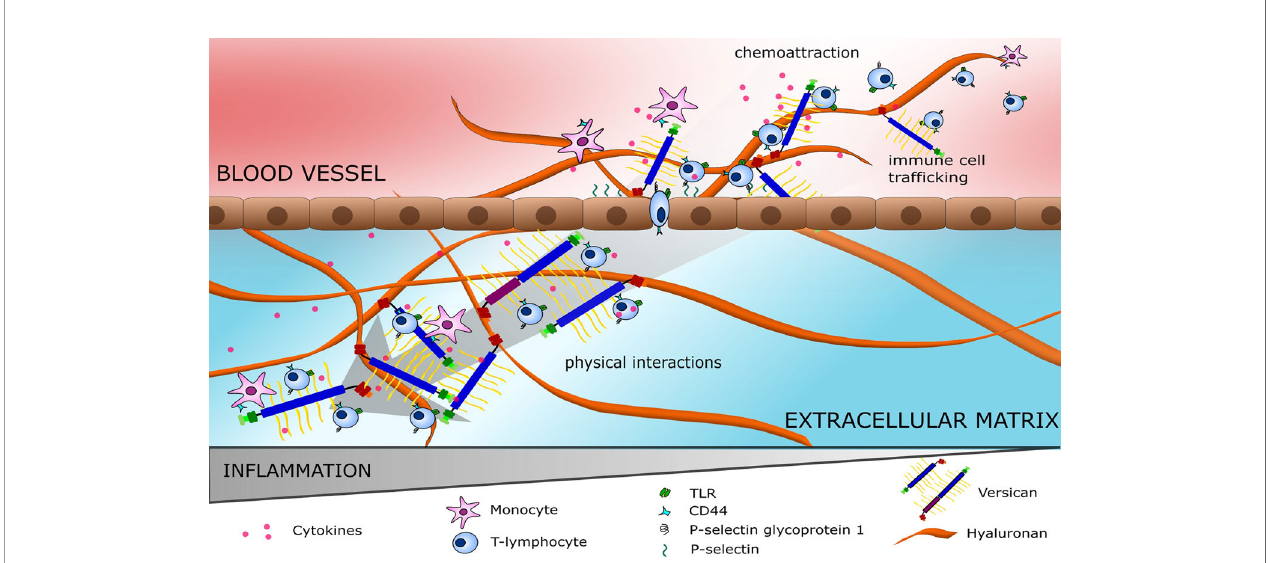
FIGURE 3 | Immune cell traf fi cking on highways of versican. Versican (V0/V1) attracts pro-in fl ammatory cytokines forming a gradient to guide immune cells. Immune cells bind to versican and hyaluronan via receptors such as TLRs, CD44 and P-selectin glycoprotein 1, mediating cell rolling followed by extravasation into the ECM. Within the ECM, a cytokine gradient is also observed with immune cells locating to areas with high versican